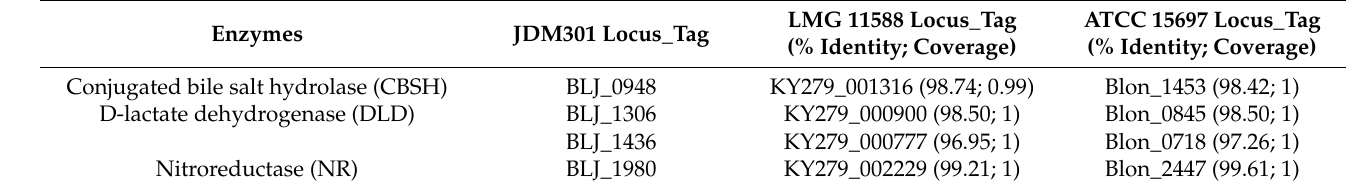
Table 6. Significant BlastP hits for putative enzymes implicated in the production of harmful me ‐ tabolites in B.infantis ATCC 15697 and LMG 11588 genomes.